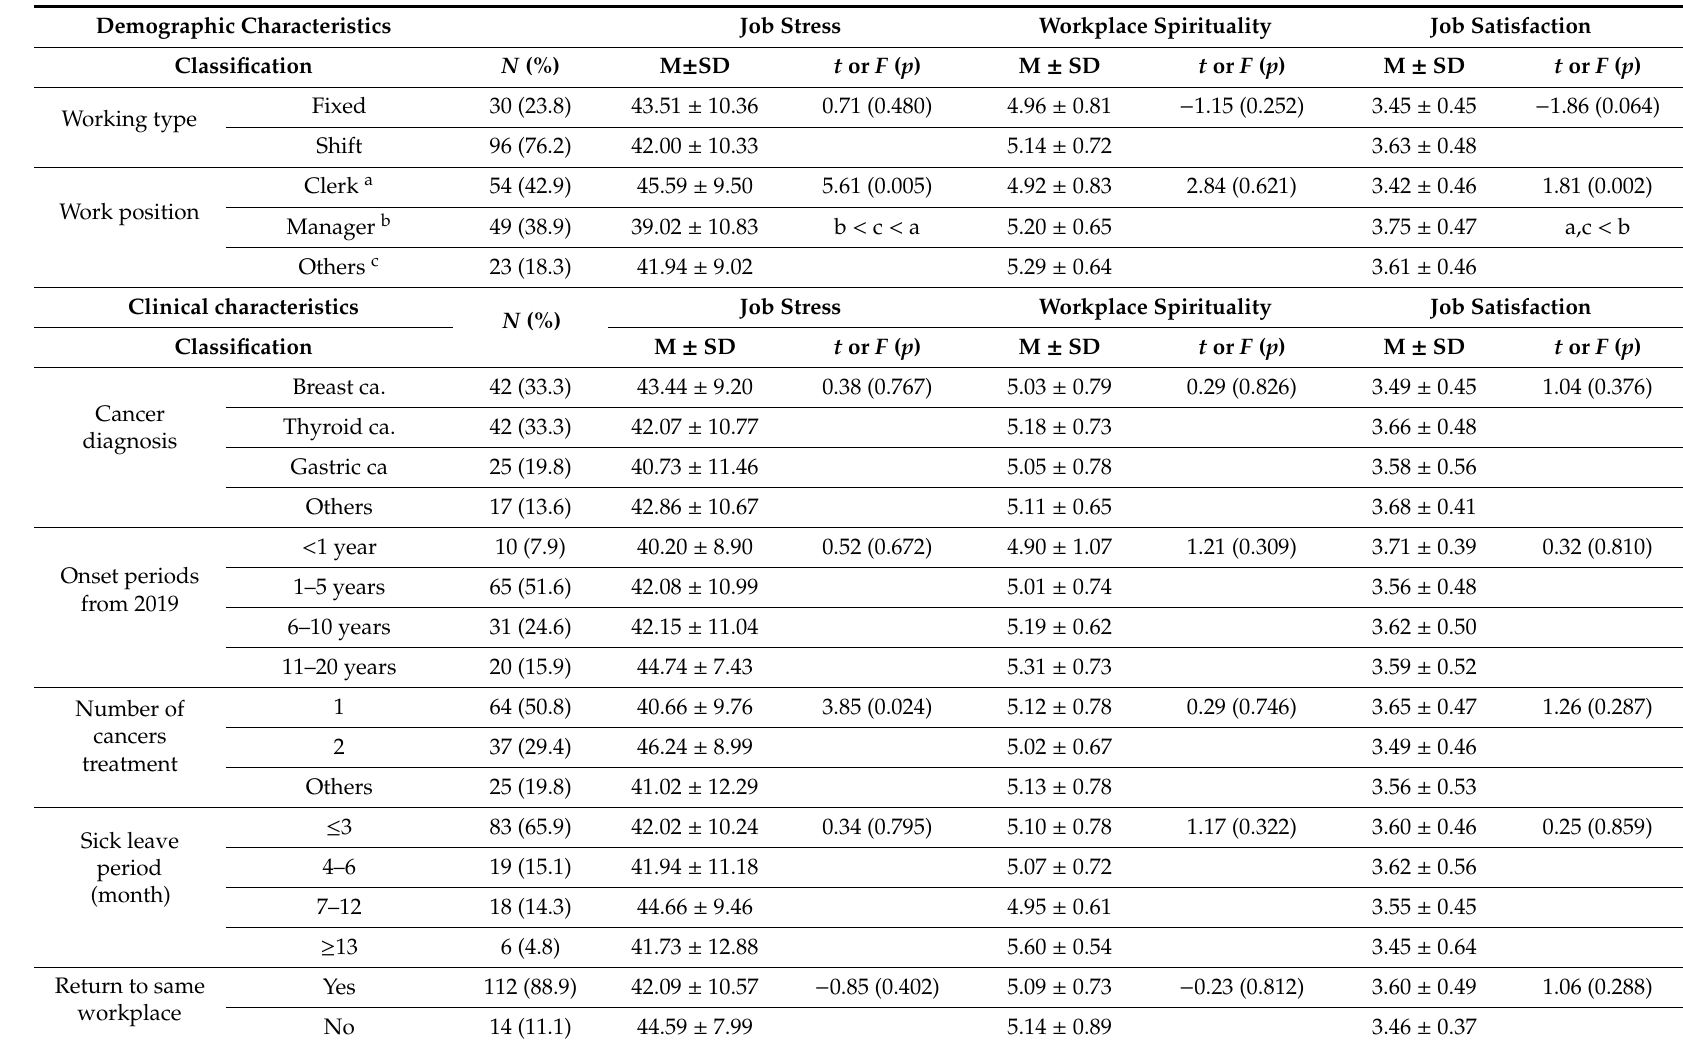
POC: Sche ff é test, a, b, c, d, e: marking of classification of